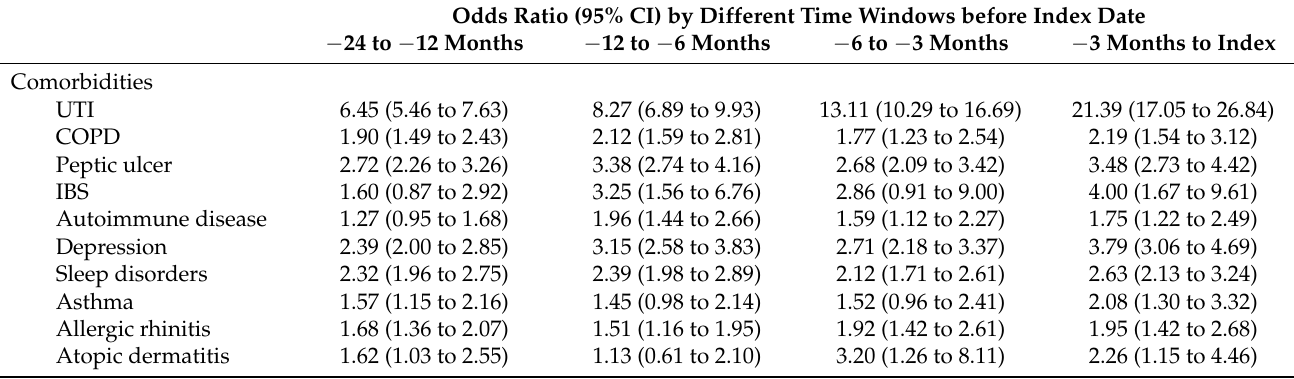
Table 2. The odds ratio of interstitial cystitis/bladder pain syndrome by time-varying defined variable. Odds Ratio (95% CI) by Different Time Windows before Index Date